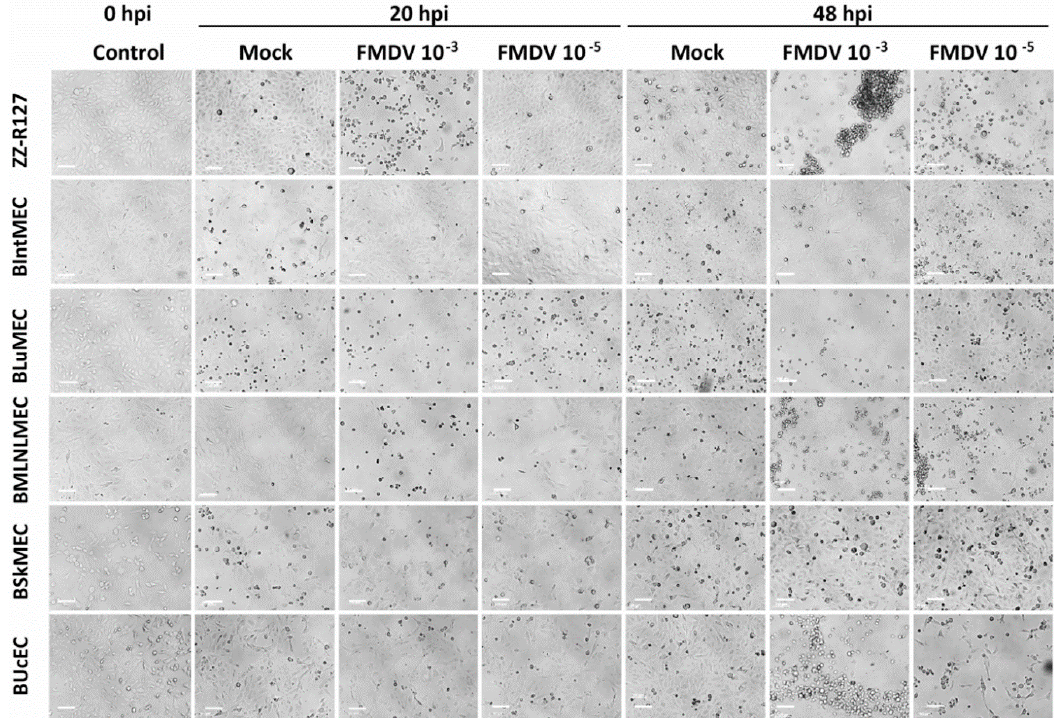
Figure 5. Viral infections of bovine endothelial cell lines by foot-and-mouth disease virus (FMDV). BIntMEC, BLuMEC, BMLNMEC, BSkMEC, and BUcEC were inoculated with FMDV strain of O serotype (2 viral doses: MOI 10 − 3 and 10 − 5 ) and monitored for cytopathic effect (CPE) during 48 h using an inverted LEICA Statif DM IL LED microscope (×10 magnification). ZZ-R127, fetal goat tongue epithelial cells, were used as positive controls. The pictures presented correspond to 20 and 48 h post-infection (hpi). Scale bars represent 100 μ m.